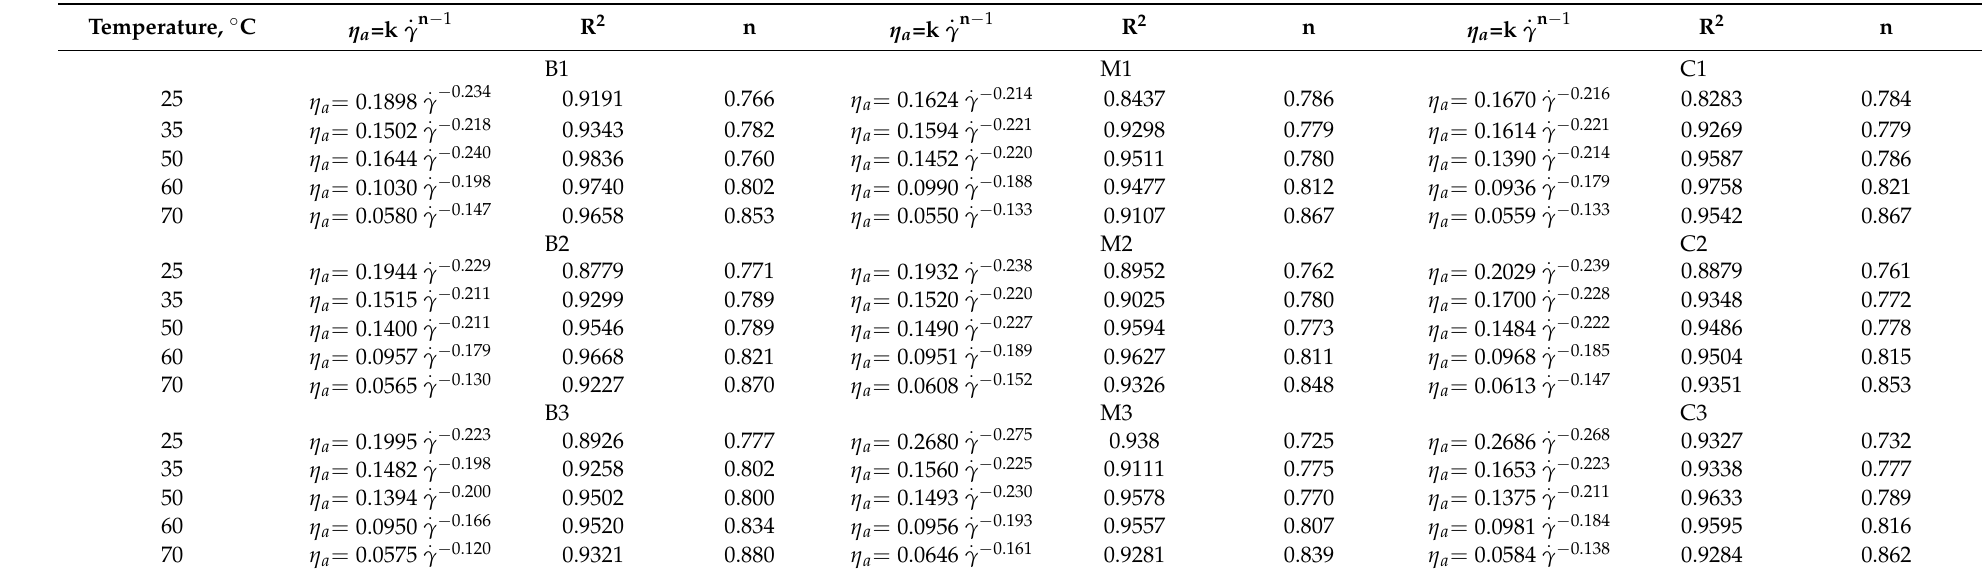
Table 5. Rheological equations for all